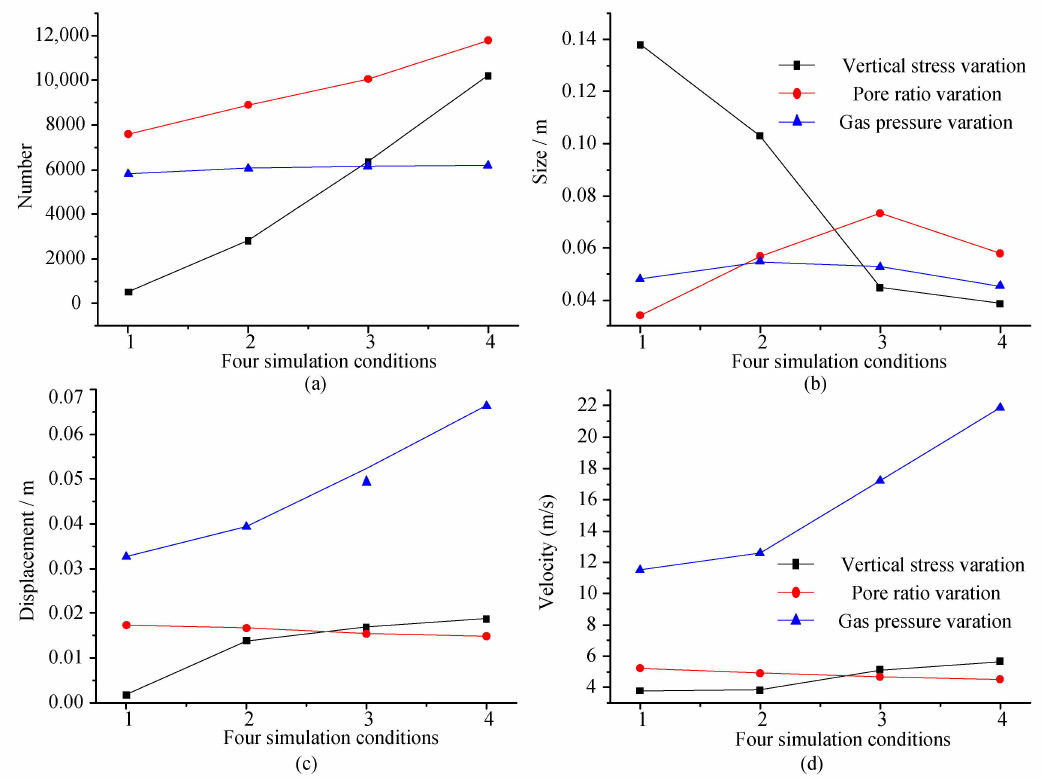
Figure 13. Comparison of the statistical results of coal failure under different simulation conditions: ( a ) fracture coal block number comparison; ( b ) maximum coal block size comparison; ( c ) maximum displacement comparison of fracture coal blocks; and ( d ) maximum velocity comparison of fracture coal